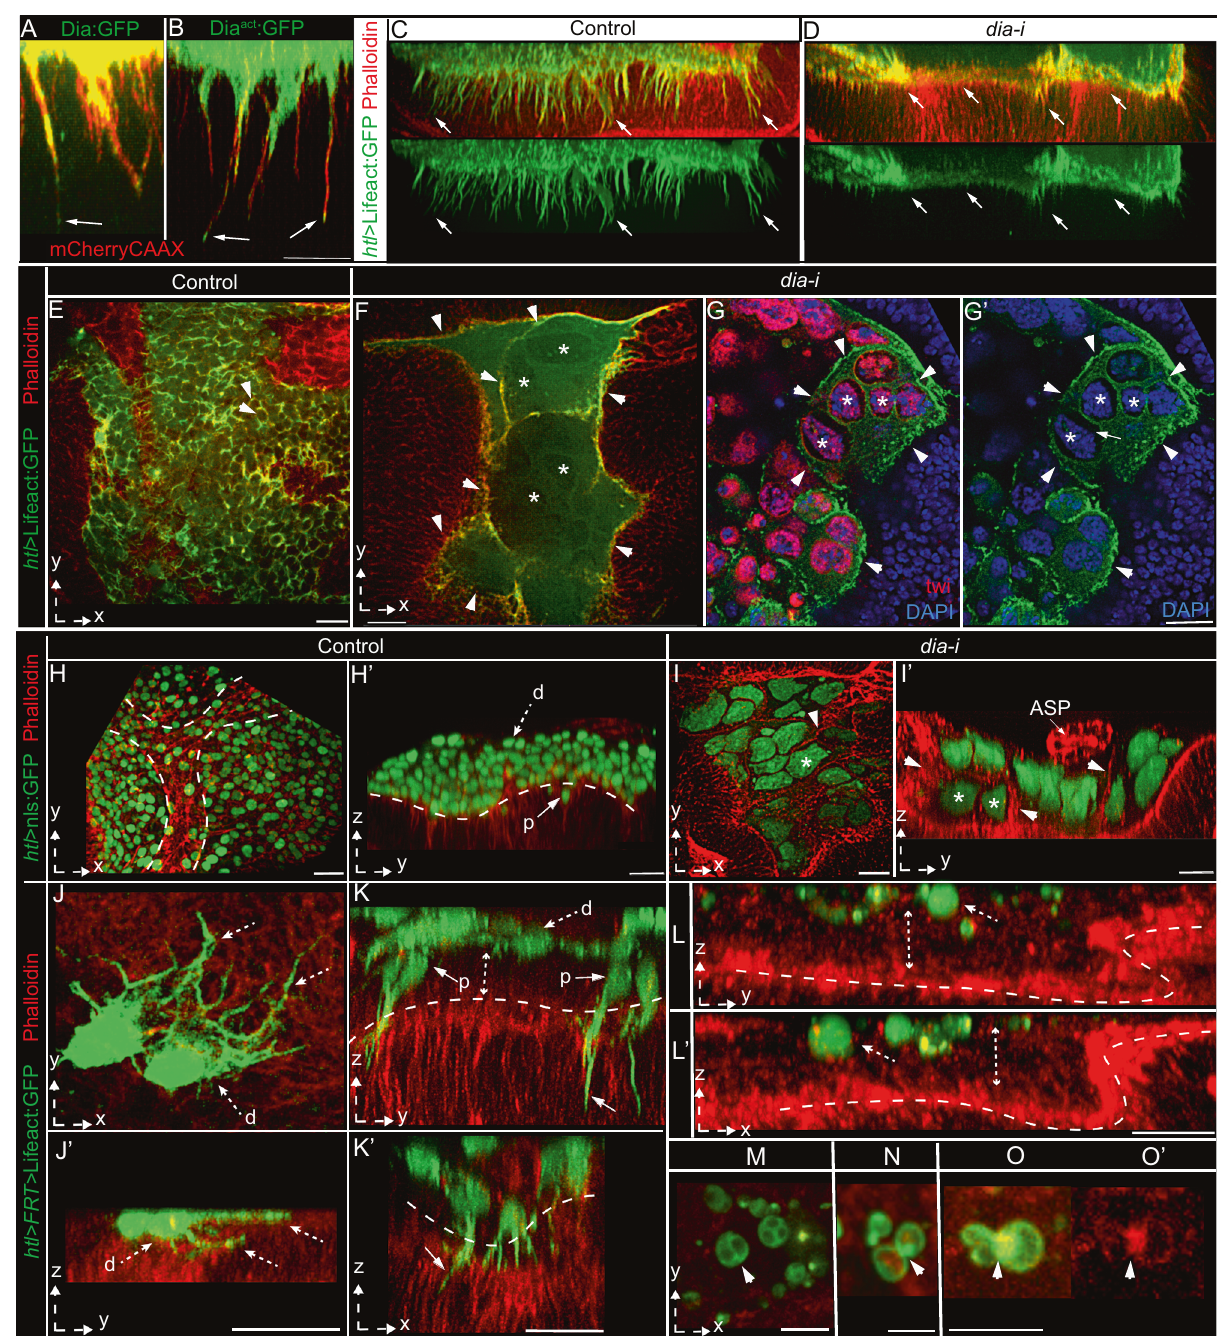
Fig. 4 Disc-cytoneme adhesion determines AMP position and fates. A – D AMP cytoneme formation depends on Dia; A , B mCherryCAAX-marked